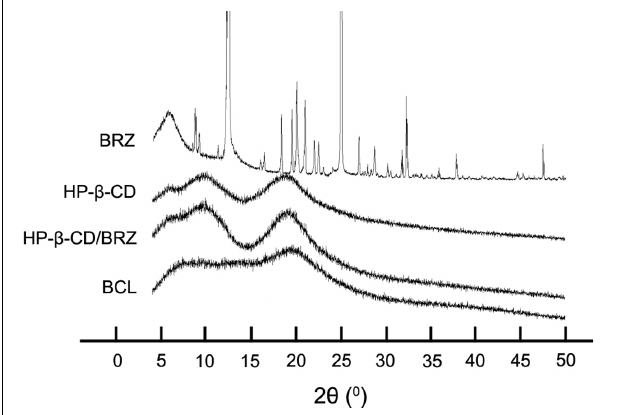
FIGURE 4 | X-ray diffractograms of BRZ, HP- β -CD, HP- β -CD/BRZ, and BCL.